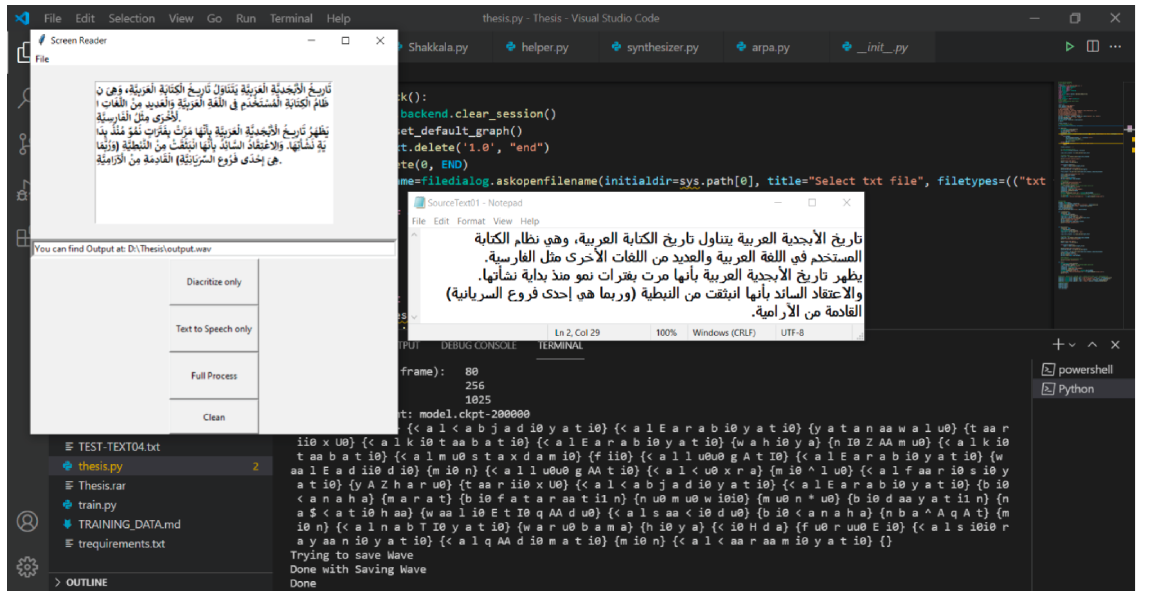
Figure 7: Output of the proposed system: after the full diacritization, the system shows the transliteration of diacritized speech, generates and plays the audio file.